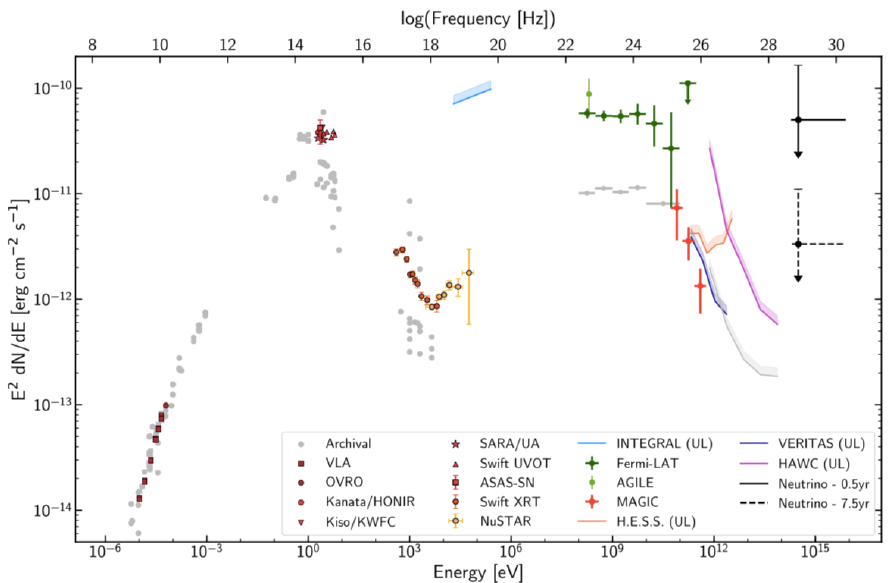
Figure 3: Spectral energy distribution for the blazar TXS 0506 + 056, based on ob- servations obtained within 14 days of IceCube-170922A. Archival observations are shown in gray to illustrate the historical flux level of the blazar in the radio to keV range. Representative ν µ + ν µ neutrino flux upper limits that produce on average one detection like IceCube-170922A over a period of 0.5 (solid black line) and 7.5 years (dashed black line) are shown assuming a spectrum of dN / dE ∼ E − 2 at the most probable neutrino energy of 311 TeV. Plot source: [ 5 ]